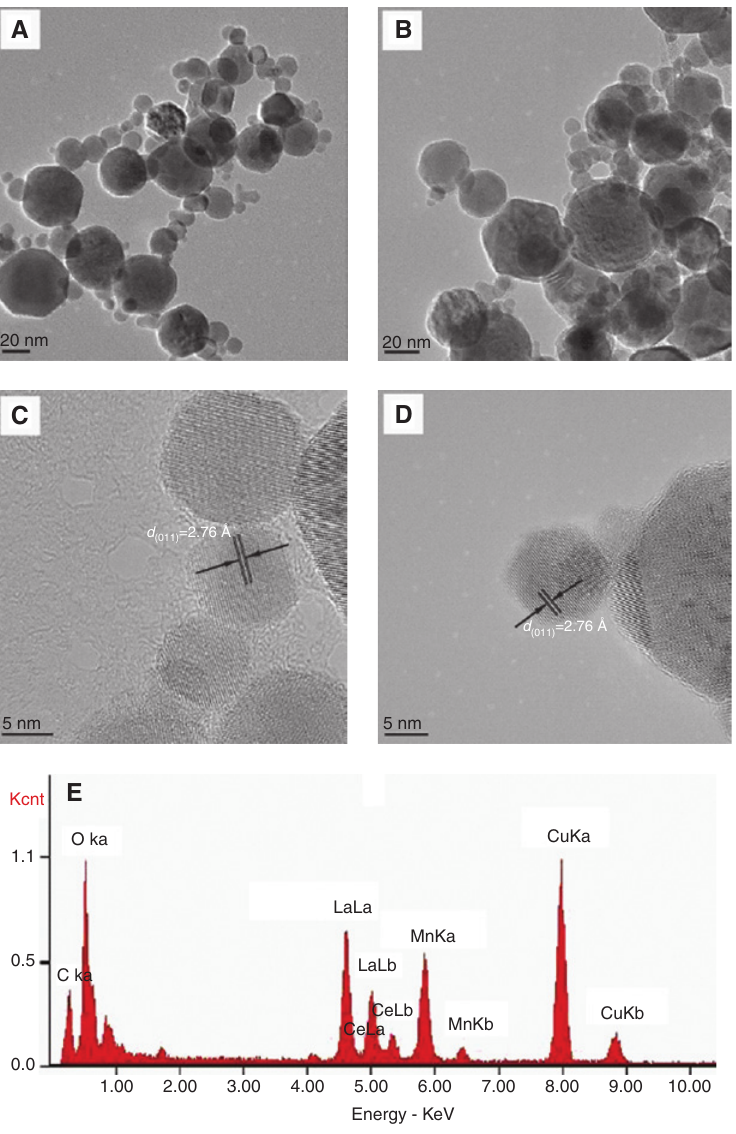
and (B) La Ce MnO perovskites; HRTEM images of (C) pure LaMnO 3 0.900 0.100 3 Ce MnO perovskites. Reproduced from [125] with 0.900 0.100 3